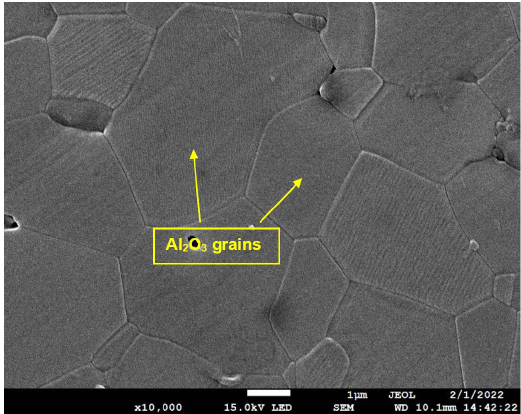
Figure 4. Compositional mapping of sample of Group B, showing the intergranular distribution of Ce and Zr elements, originating from Ce-TZP